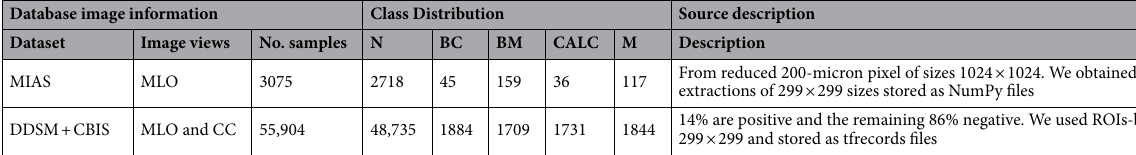
of the proposed CNN and wCNN architectures since the MIAS samples are different from the DDSM + CBIS. GAN image augmentation: sample generated. The image samples shown in the last section from the two databases consist of abnormalities and normal cases. Those in the abnormalities category with malignancy were further categorized into mass and calcification abnormalities. These two classes of abnormalities often dominate most publicly available databases and are reported to be commonly diagnosed. We, however, note that